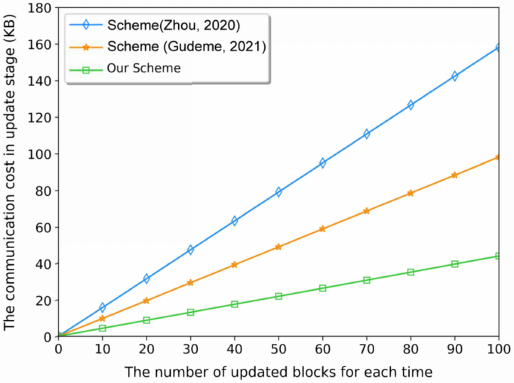
Figure 10. The communication cost at the update stage